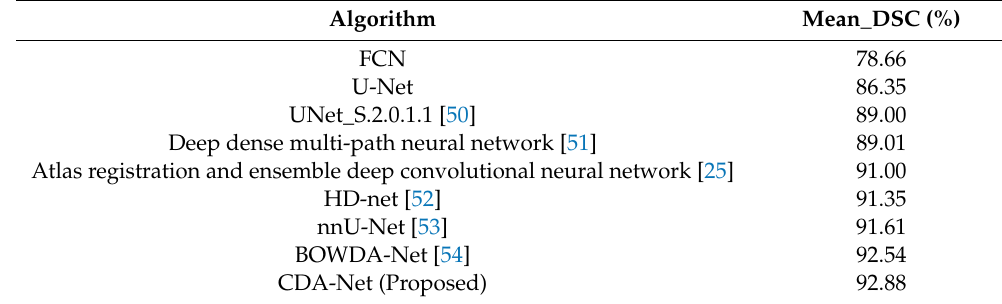
Table 2. Comparison results with state-of-the-art